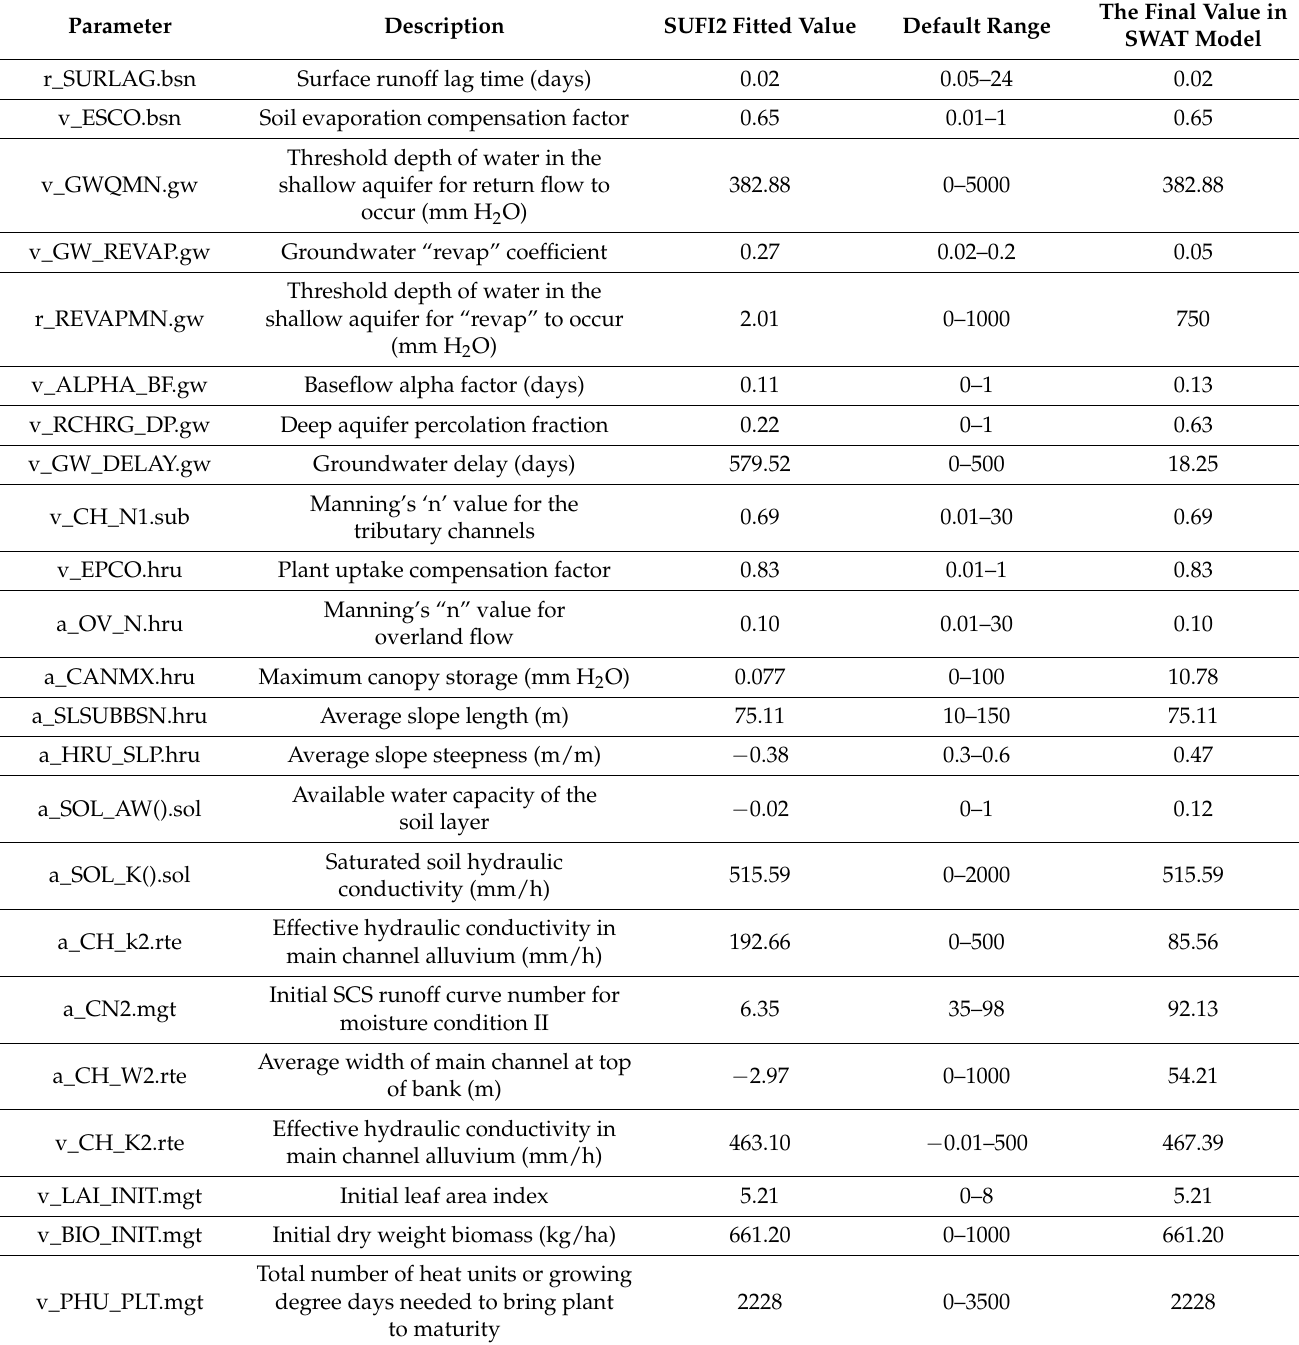
Table 2. Parameters sensitive to streamflow, their default range, fitted value during calibration and final values used. Parameter Description SUFI2 Fitted Value Default Range